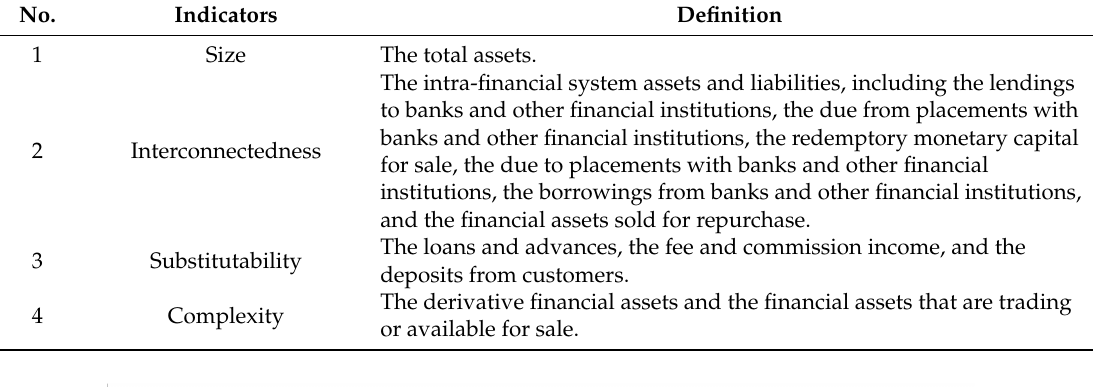
Table 5. The indicators used in the indicator approach.